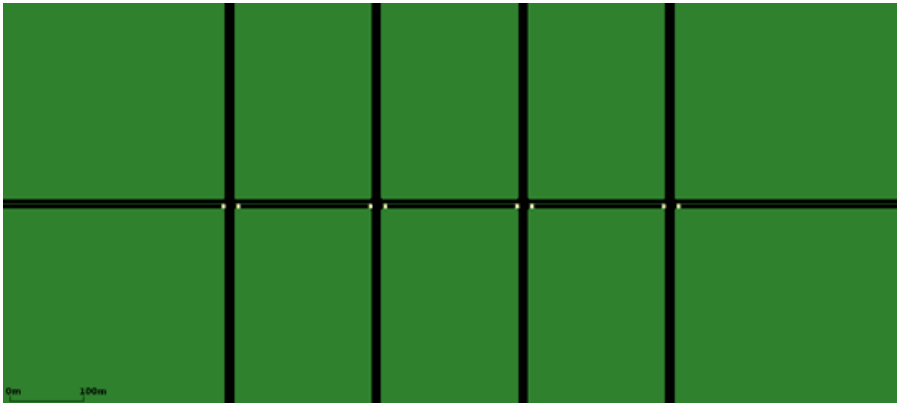
Figure 10. An arterial road with 4